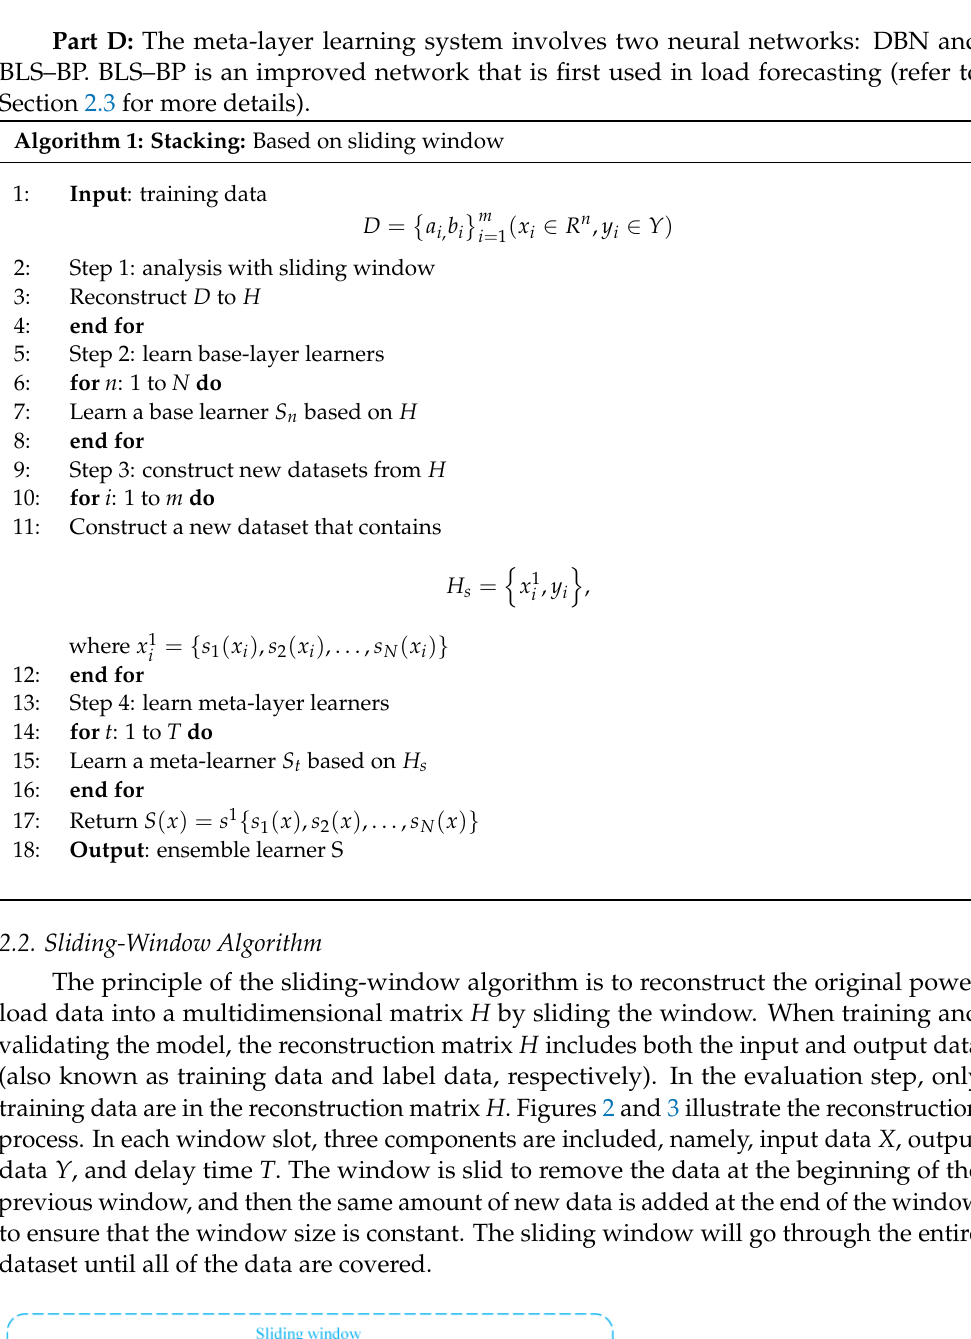
Figure 3. The reconstructed matrix. 2.3. Stacking Algorithm 2.3.1. Algorithm Structure Figures 4 and 5 show the framework structure of the stacking algorithm; the specific process is as follows: 1.